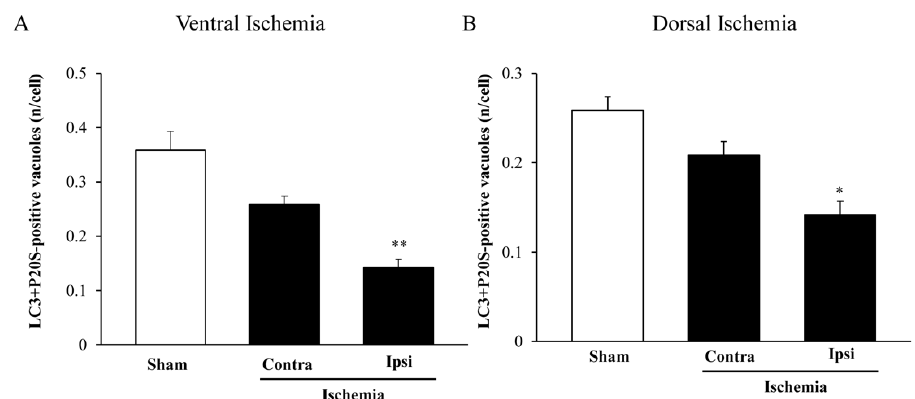
Figure 16. LC3 + P20S vacuoles (autophagoproteasomes) decrease within area penumbra . Graphs report the number of LC3 + P20S immuno-gold double-stained vacuoles per cell both in the ventral ( A ) and dorsal ( B ) region. Dorsal or ventral placement of area penumbra was dissected in the ipsilateral (right) hemi-encephalon of ischemic mice (Ipsi/Ischemia, n = 6), the analogous area was analyzed from the contralateral side (Contra/Ischemia, n = 6) and from the ipsilateral hemi-encephalon of sham mice (Sham, n = 6). Values are given as the mean ± S.E.M. per cell from a total of 120 cells for each group. * p ≤ 0.05 compared with Sham, ** p ≤ 0.05 compared with Sham and Contra/Ischemia. ( A ) df = 2, F-value = 20.650, p < 0.0001; ( B ) df = 2, F-value = 14.510, p = 0.0003.